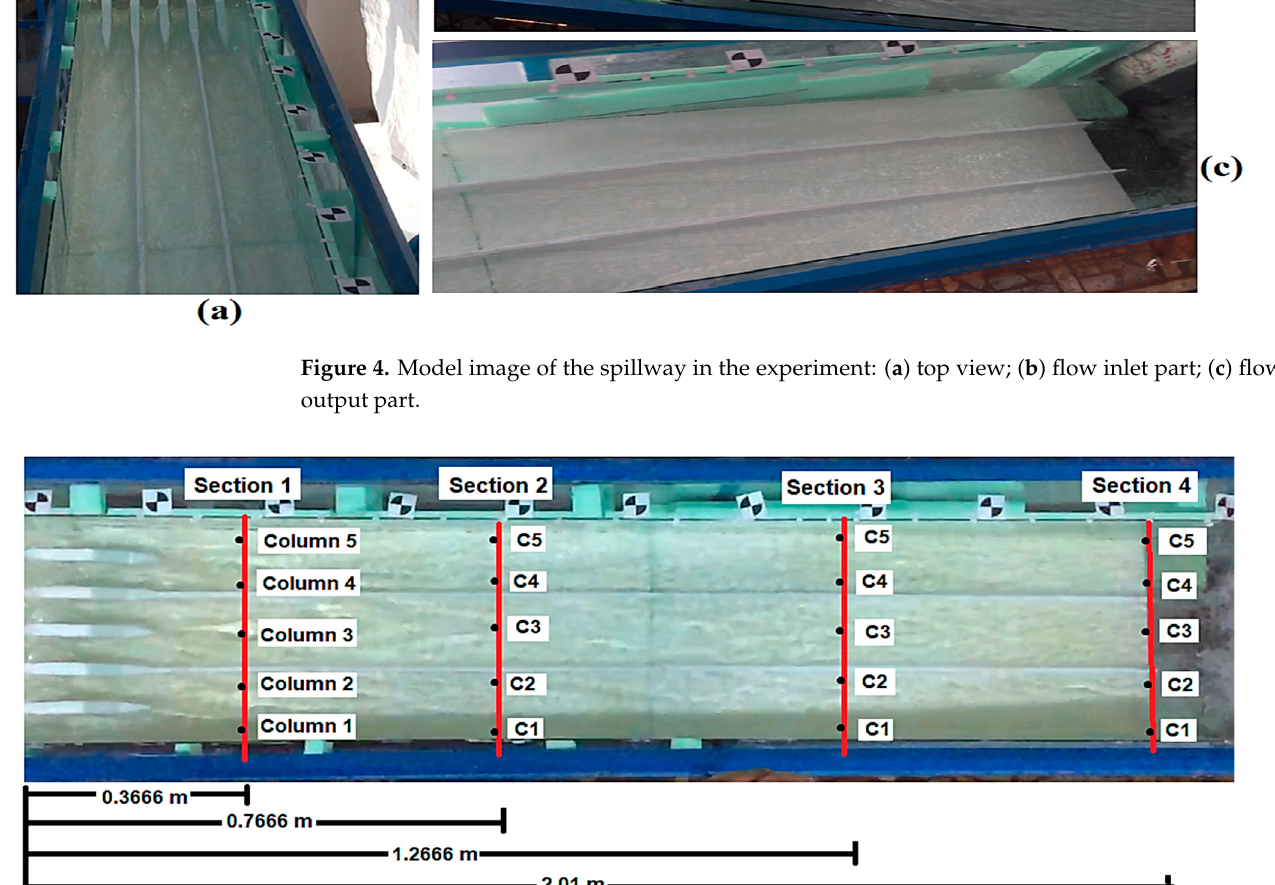
Figure 4. Model image of the spillway in the experiment: ( a ) top view; ( b ) flow inlet part; ( c ) flow output part.